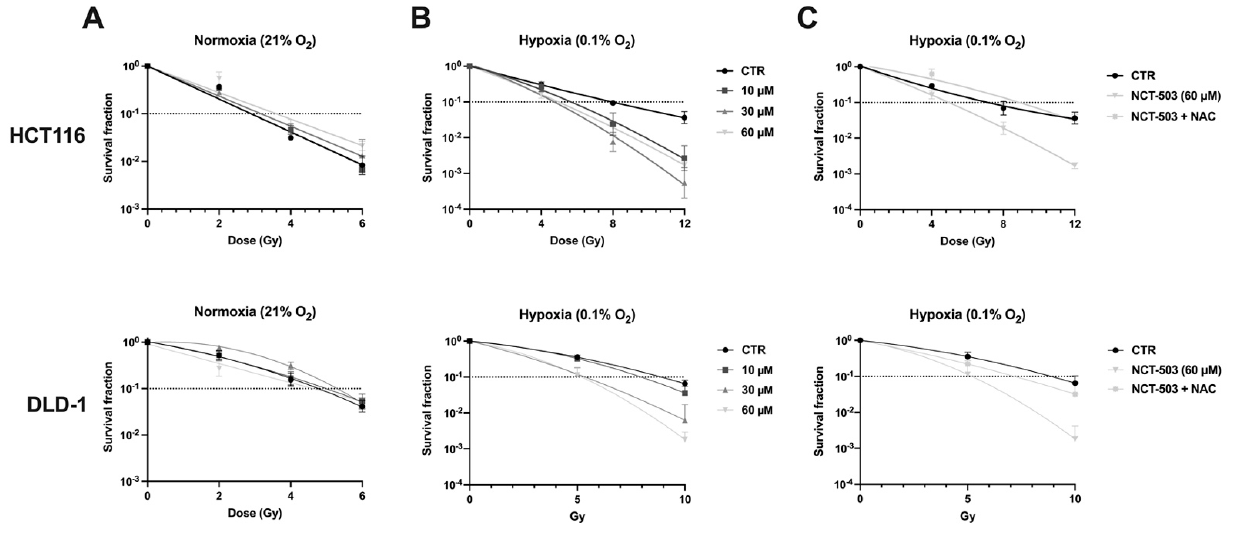
Figure 6. Inhibition of PHGDH radiosensitizes human hypoxic colorectal cancer cells through excessive ROS. HCT116 (top) and DLD-1 (bottom) cells were treated with NCT-503 (16 h) at indicated concentrations, irradiated and reseeded for colony formation assay. ( A ) Dose–response curves under normoxic ( B ) and hypoxic conditions. ( C ) Dose–response curve under hypoxic conditions with treatment of 60 µM NCT-503 with the addition of NAC.